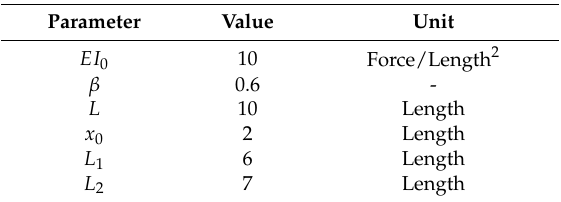
Table 1. Value of Constant Parameters in Example-1 and Example-2.